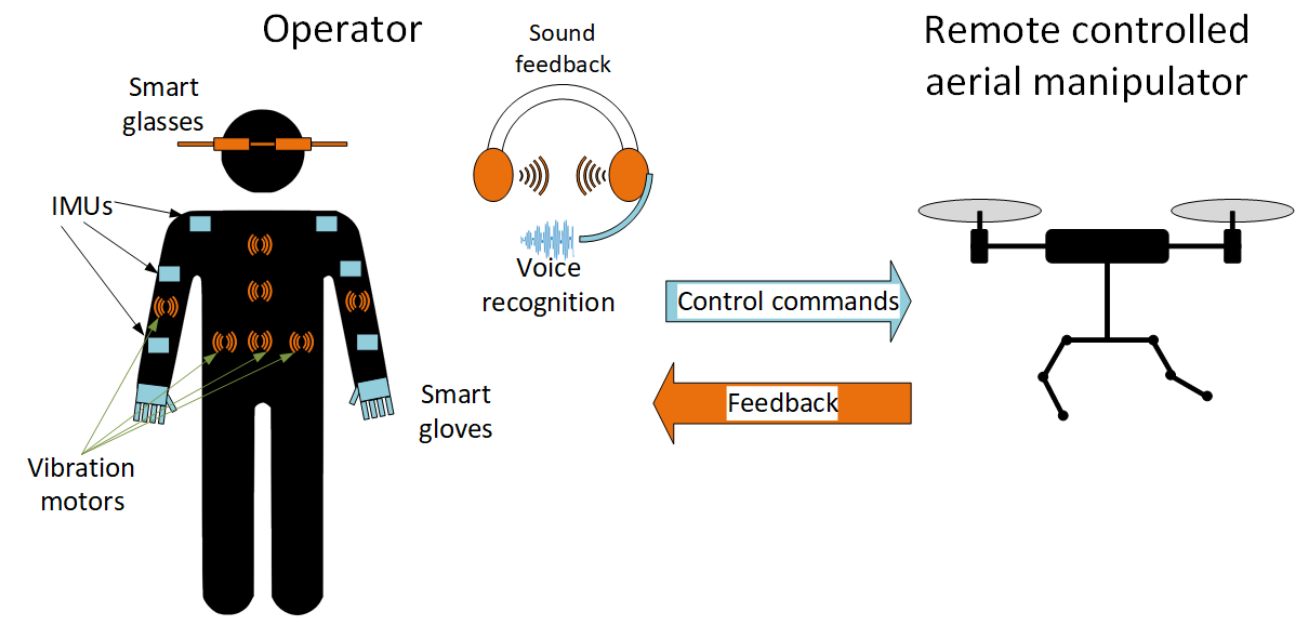
Figure 11. Augmented human–machine